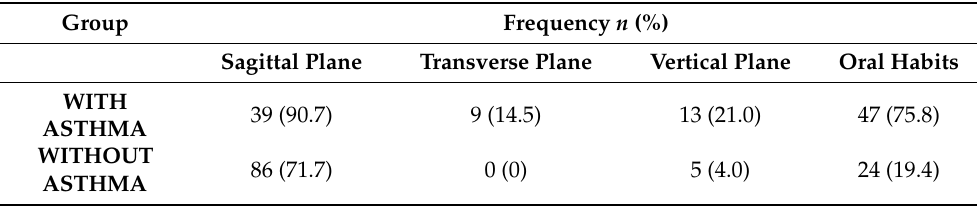
Table 1. Frequency of occlusion alterations in the studied groups.